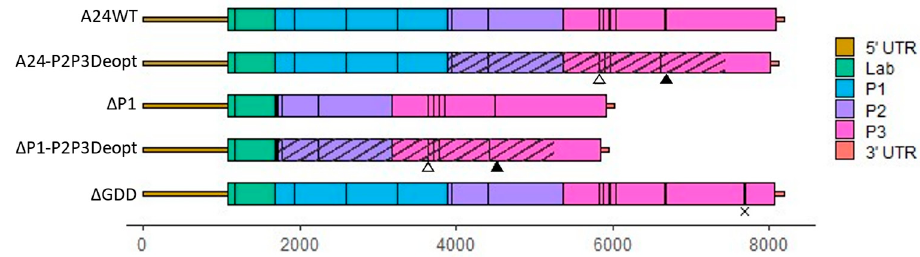
Table 1. Genotypic and phenotypic characteristics of viral RNAs.